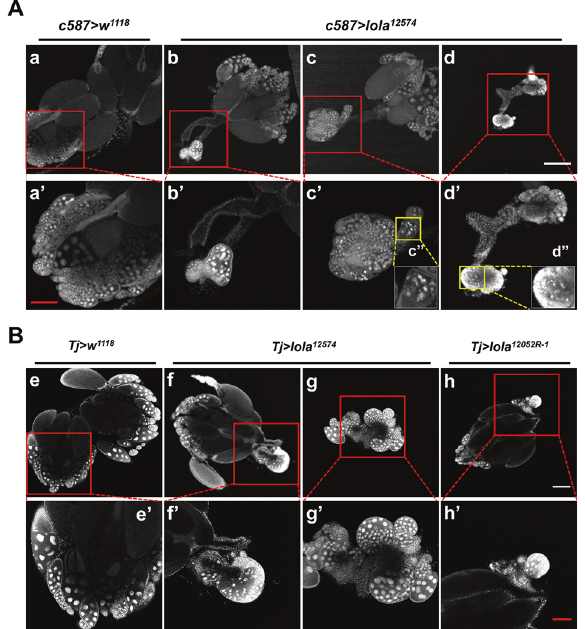
Fig. 3 RNAi of lola results in smaller ovaries and fewer ovarioles. A Phenotypes of ovaries from the c587 > w 1118 and c587 > lola 12574 lines. Ovaries with normal size and number of ovarioles ( a , a ’ ) from the c587 > w 1118 control line ( n = 25), and ovaries with either one ( b , c ) or both ( d ) in smaller size and fewer ovarioles ( c ’ ) or lacking ovarioles ( b ’ , d ’ ) from the c587 > lola 12574 RNAi line ( n = 58). B Phenotypes of ovaries from the Tj > w 1118 , Tj > lola 12574 and Tj > lola 12052R-1 lines. Ovaries w ith normal size and number of ovarioles ( e , e ’ ) from the Tj > w 1118 control, ovaries with either one ( f ) or both ( g ) in smaller size from the Tj > lola 12574 RNAi line, and ovaries with one in smaller size ( h ) from the Tj > lola 12052R-1 RNAi line. a ’ - h ’ Higher magni fi cations of the ovary regions from the corresponding ovaries ( a – h ). c ” , d ” Higher magni fi cations of the ovary regions from the corresponding ovaries ( c ’ , d ’ ) showing DNA fragmentations. Scale bar: 200 µm in a – h , and 100 µm in a ’– h ’ (Fig. 5B (a)). However, in 43% of ovaries from the c587 > lola 12574